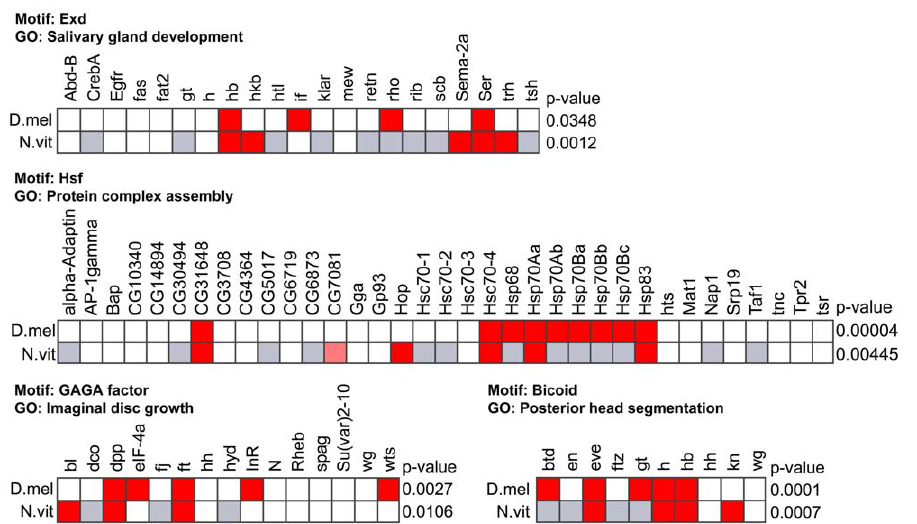
Figure 5. Example of conserved motif – GO associations between Drosophila and Nasonia . All genes in a GO category in Drosophila are shown as columns, with grey indicating that the ortholog was not found in Nasonia . Dark red indicates motif presence at the threshold used, light red indicates medium strength motif presence, white indicates motif absent in the gene’s promoter. The p-value of association between motif and GO category is shown for each species, at the right end of its row.